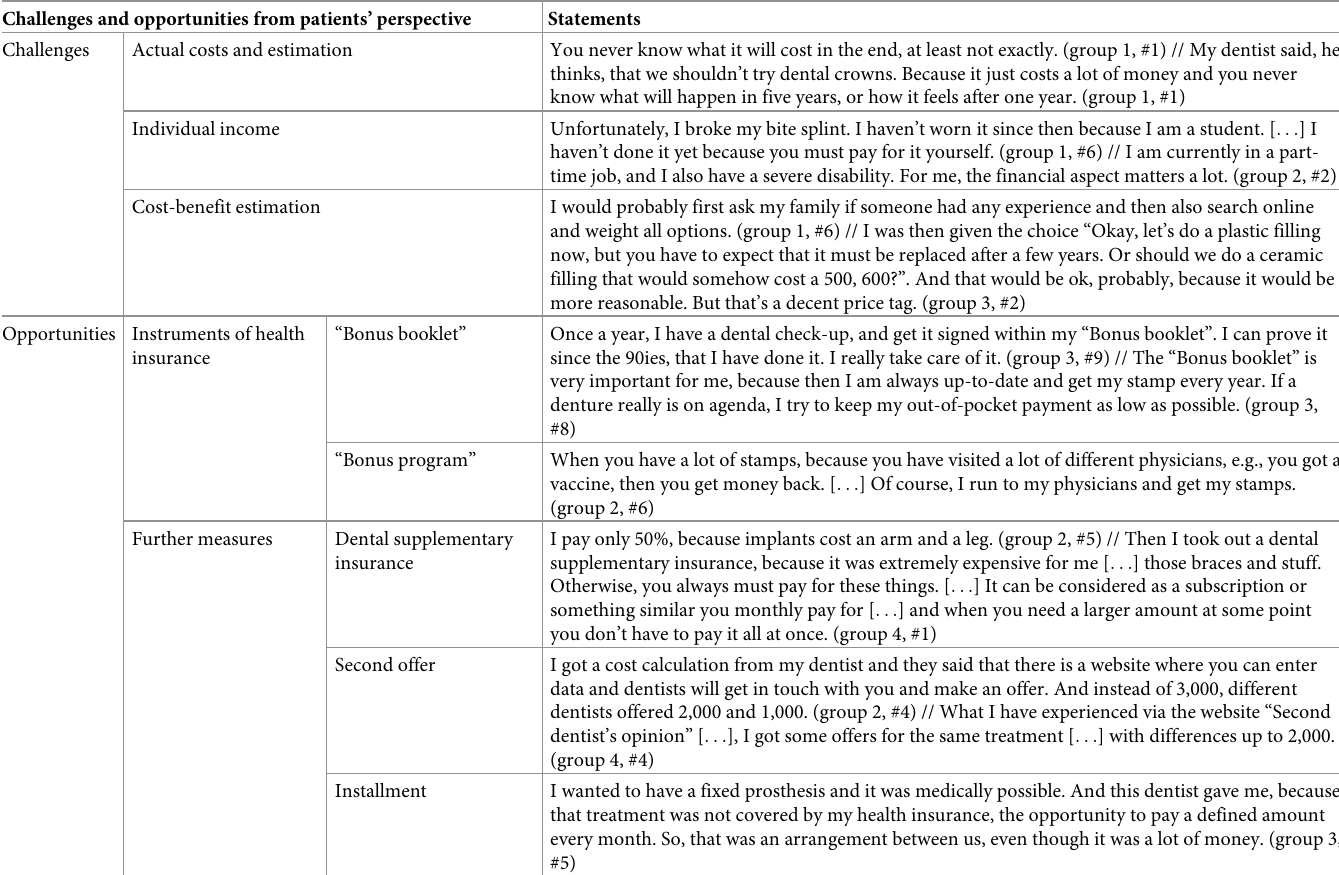
Table 2. Challenges and opportunities of financing dental care from patients’ perspective, and